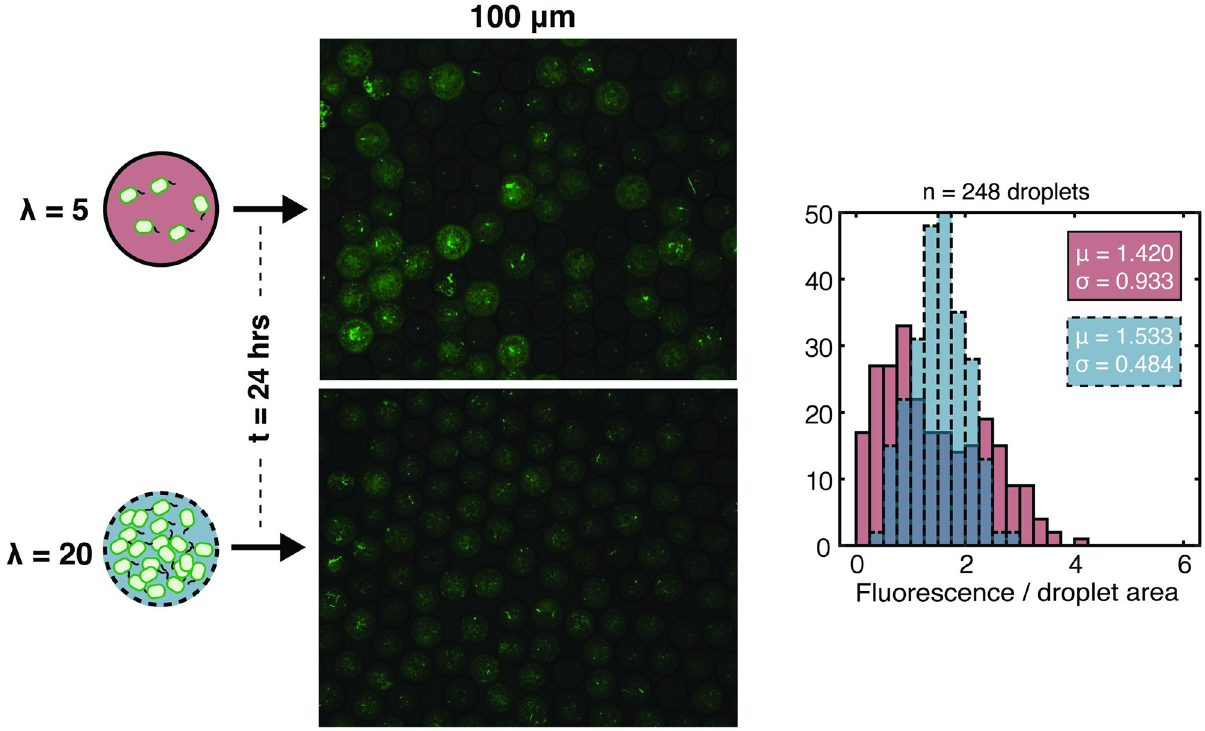
Fig 2. Droplet-to-droplet variation of fluorescence for cultivation of S1 Δ ilvD with λ = 5 and λ = 20 cells/droplet in droplets in droplets of 100 μ m diameter. Droplet-to-droplet variation is illustrated in representative images of populations of droplets after cultivation for 24 hours under both conditions. Image analysis of a large population of droplets (248 droplets under each condition) was performed to quantify the degree of droplet-to- droplet fluorescence variation through histograms with associated statistics (mean and standard deviation). The distribution and statistics of the population under the λ = 5 initial condition is in magenta with a solid boundary; while those under the λ = 20 condition in blue with a dashed boundary.